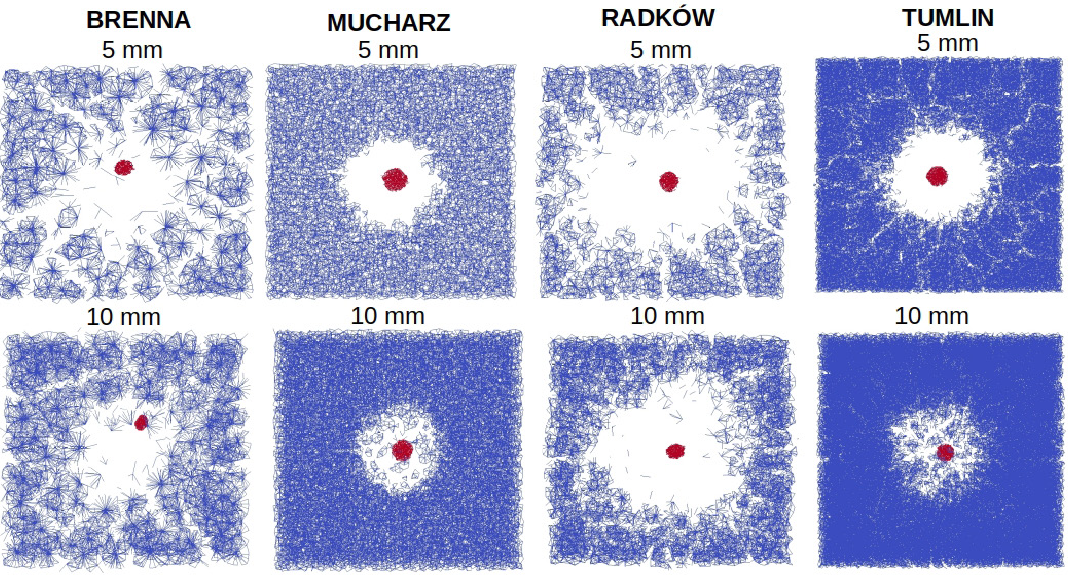
Figure 17: Network of fractures which appeared in the sample after impact resistance test. View of